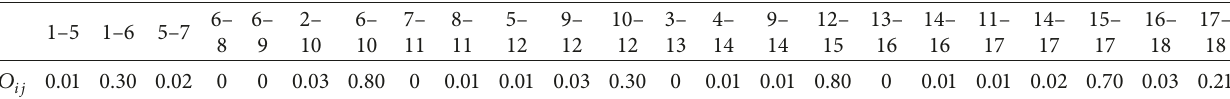
Table 4: The optimized overlap rate of each activity pair with the combinatory method.